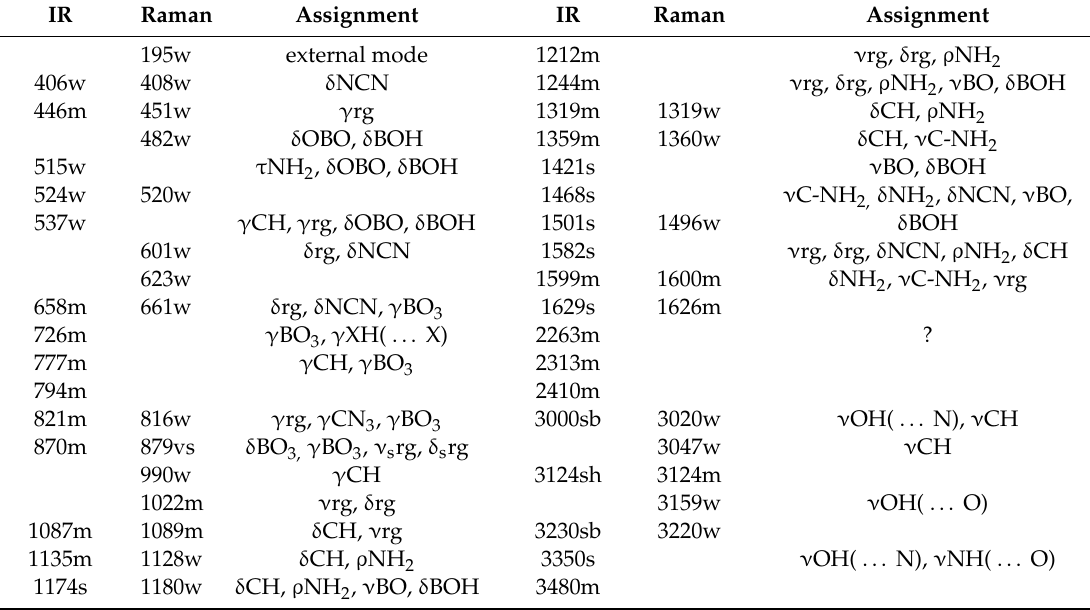
Table 4. Recorded FTIR and FT Raman maxima (cm − 1 ) of 2-AMP(H 3 BO 3 ) 2 and their